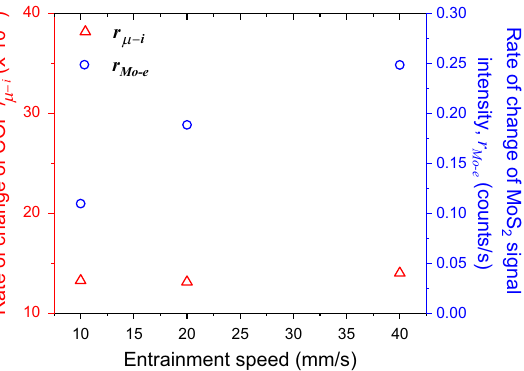
Figure 11. The accumulation rate outside the contact track increases linearly with speed (number of passes), while the rate of change of friction coefficient remains constant. Test conducted at 80 °C, applied load = 70 N and SRR = 150%.